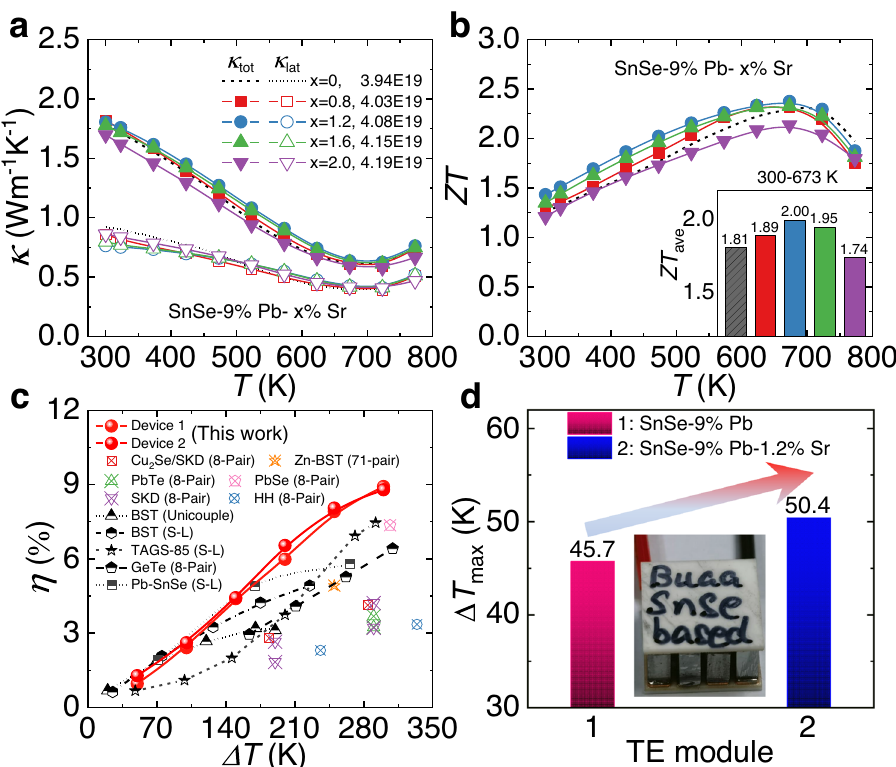
Fig. 6 | Thermal transports, ZT , and device ef fi ciencies for SnSe-9%Pb-x%Sr crystals.a Totalthermalconductivity κ tot and lattice thermalconductivity κ lat . b ZT and ZT ave at300 – 673K. c Comparisonsontheexperimentalconversionef fi ciencies η between the devices in this study (fabricated by using the SnSe-9%Pb − 1.2%Sr crystals) and the reported results among comparable temperature differences Δ T